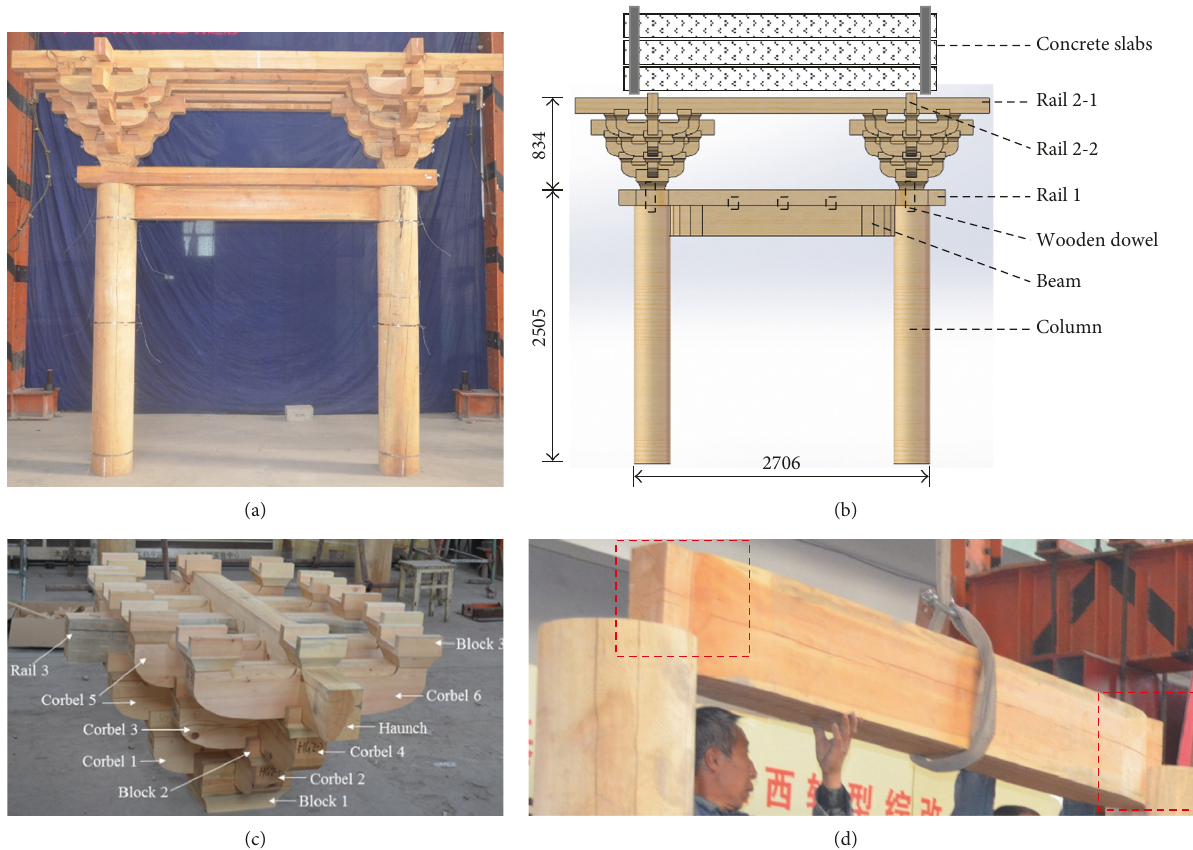
Figure 2: Test model with dimensions in mm. (a) Full-scale model; (b) elevation of the full-scale model; (c) dissembled view of the bracket set; (d) dovetailed mortise and tenon